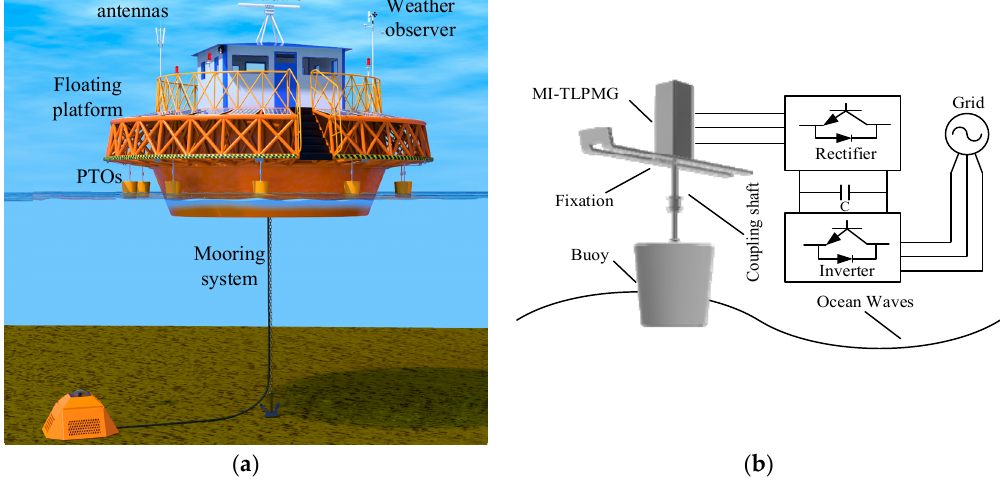
Figure 1. The system of ocean wave energy conversion: ( a ) The system schematic; ( b ) The schematic of power take-off (PTO).